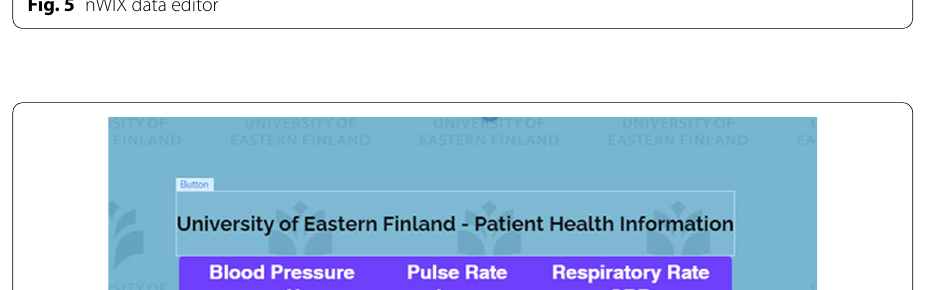
Fig. 5 nWIX data editor